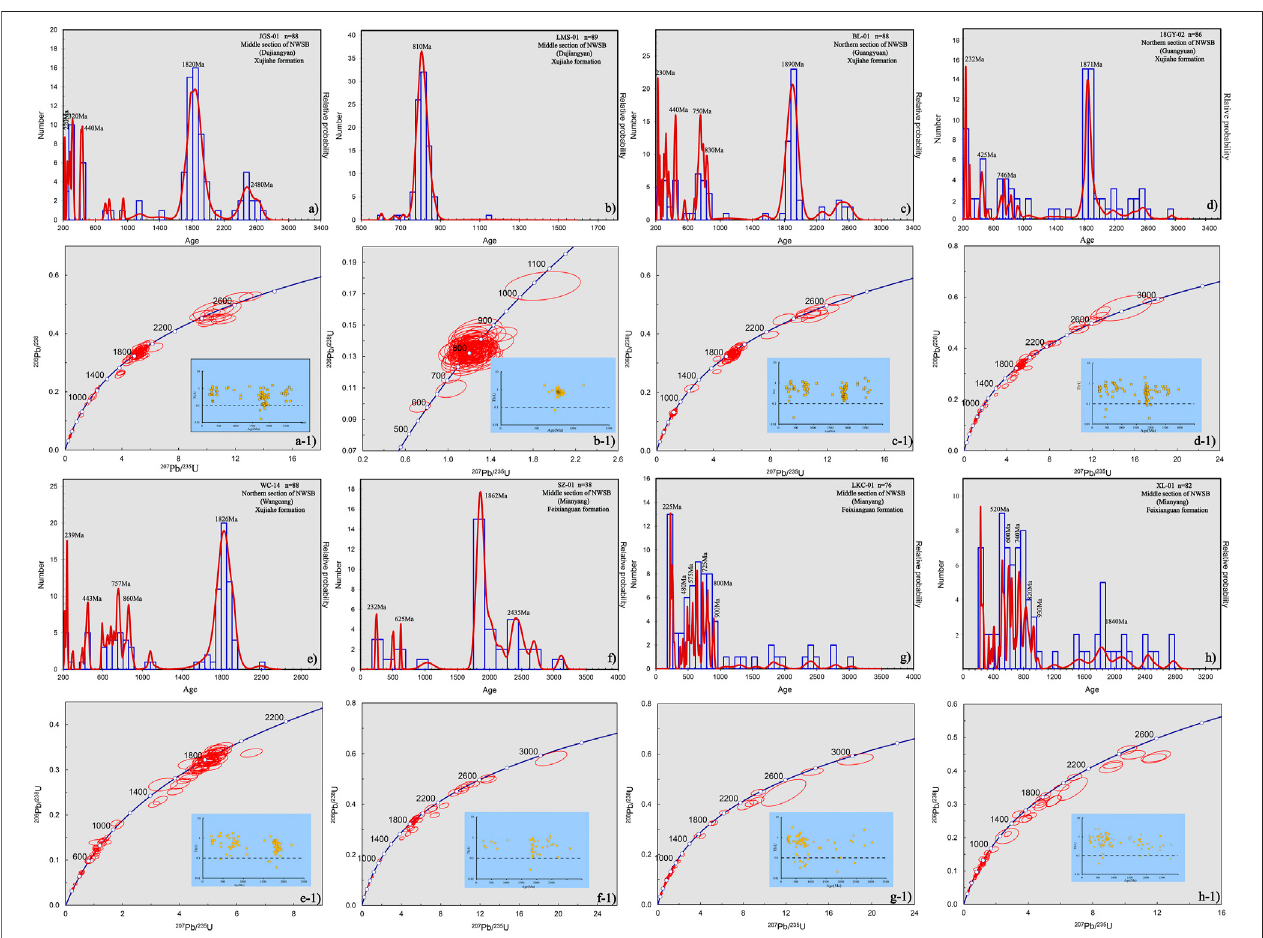
FIGURE 6 | Histogram diagram of all detrital zircons in our study (A)-H)) and their corresponding U – Pb concordia with Th/U diagrams (A-1)-H-1)).